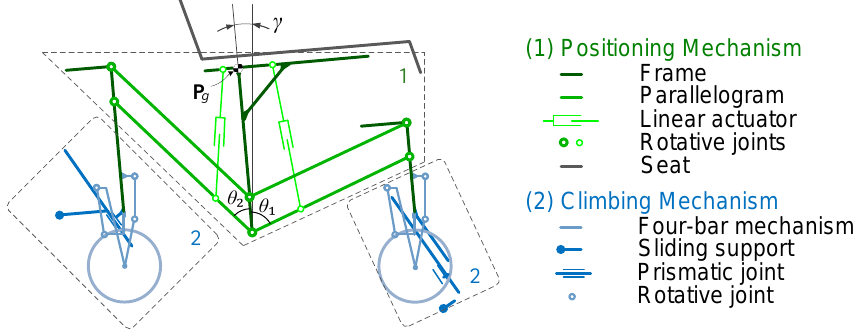
Figure 2. Kinematic scheme of the SCMS: (1) positioning mechanism, which is responsible for ensuring the posture of the entire vehicle; (2) climbing mechanism, which is responsible for surpassing the